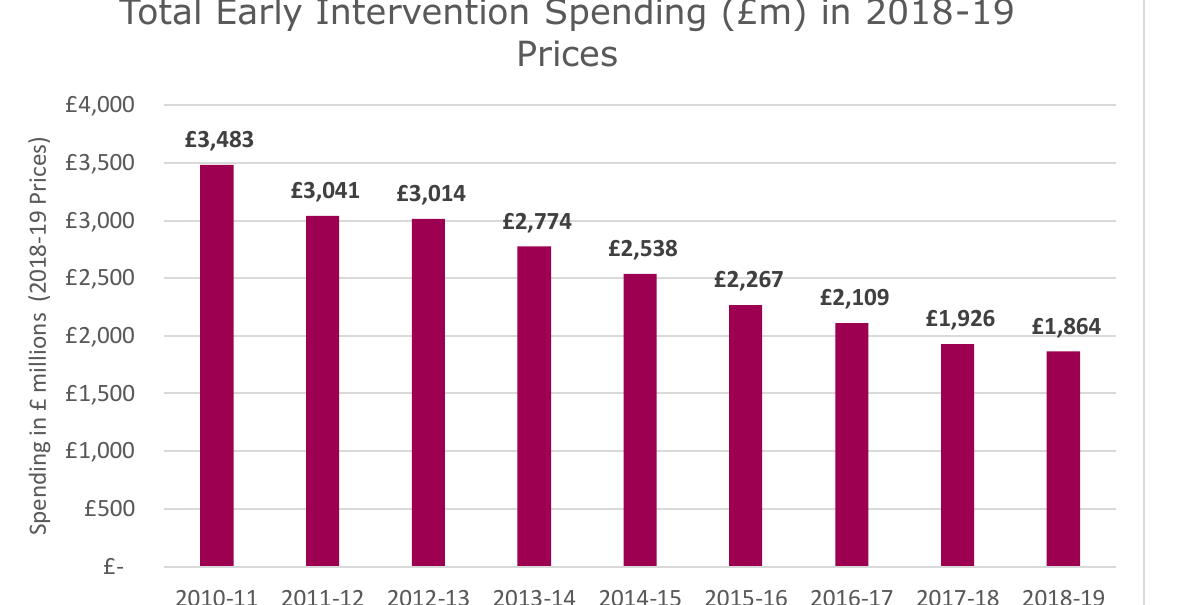
Spend in 2010/11 (mn)